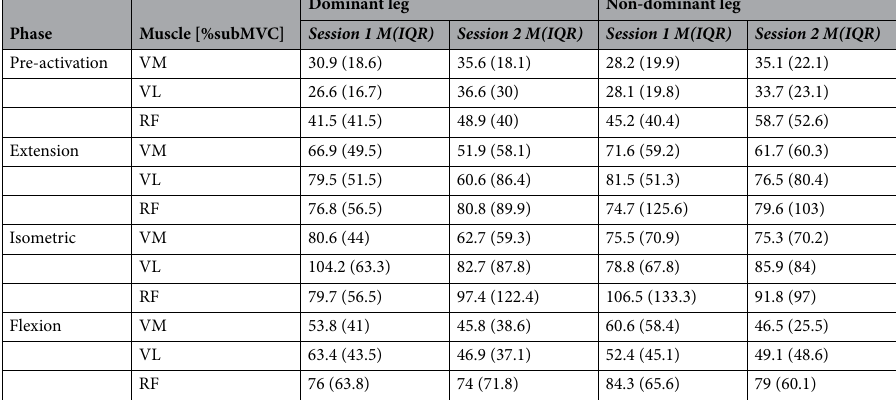
Table 3. Neuromuscular activity (% of the submaximal voluntary contraction) per leg dominance and session. subMVC submaximal voluntary contraction; M median; IQR interquartile range.